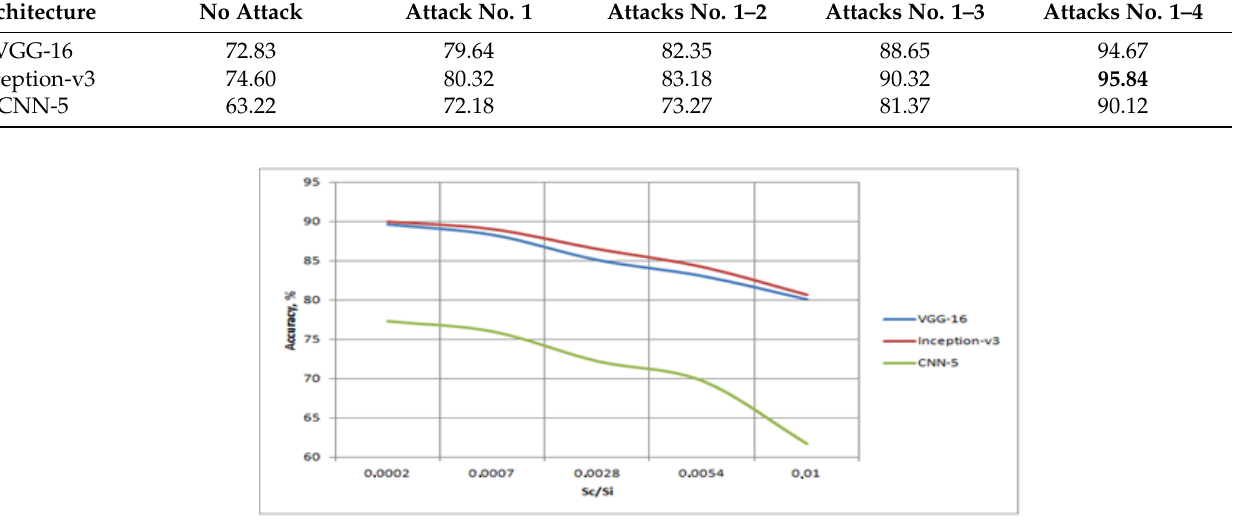
Figure 8. Dependence of accuracy on the size of distortions in Attack No. 3.